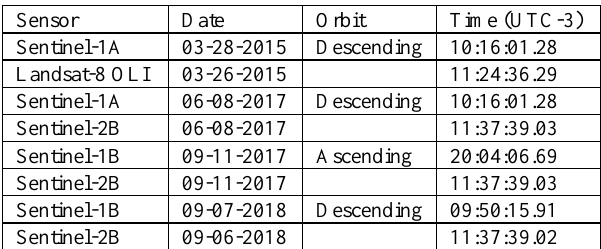
Table 1. Available radar and multispectral satellite